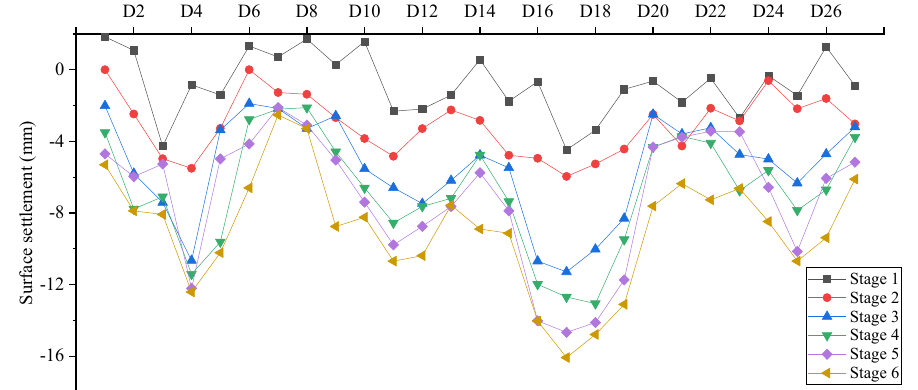
Figure 22. Surface deformation of excavation in the central district.